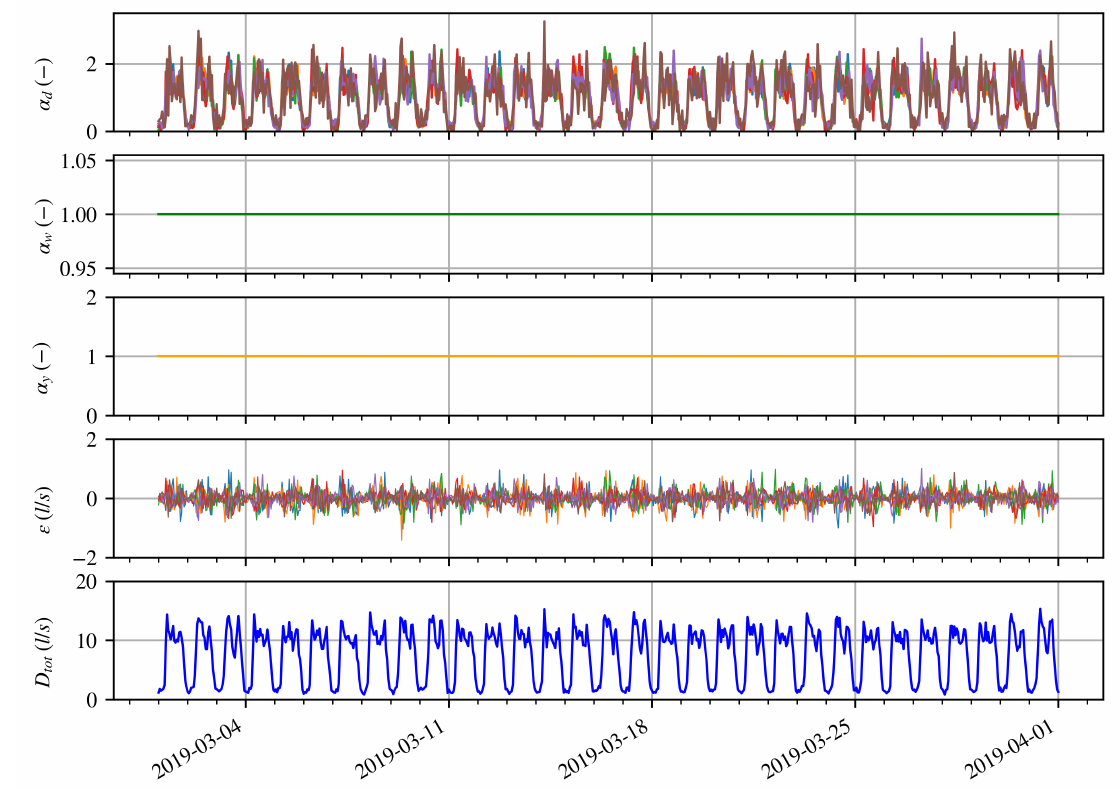
Figure 9. Water request components for the Egna test case. Starting from the top, the first represents the daily pattern, the second the weekly pattern, and the third the yearly one. The fourth plot represents the random components and the fifth the resulting water